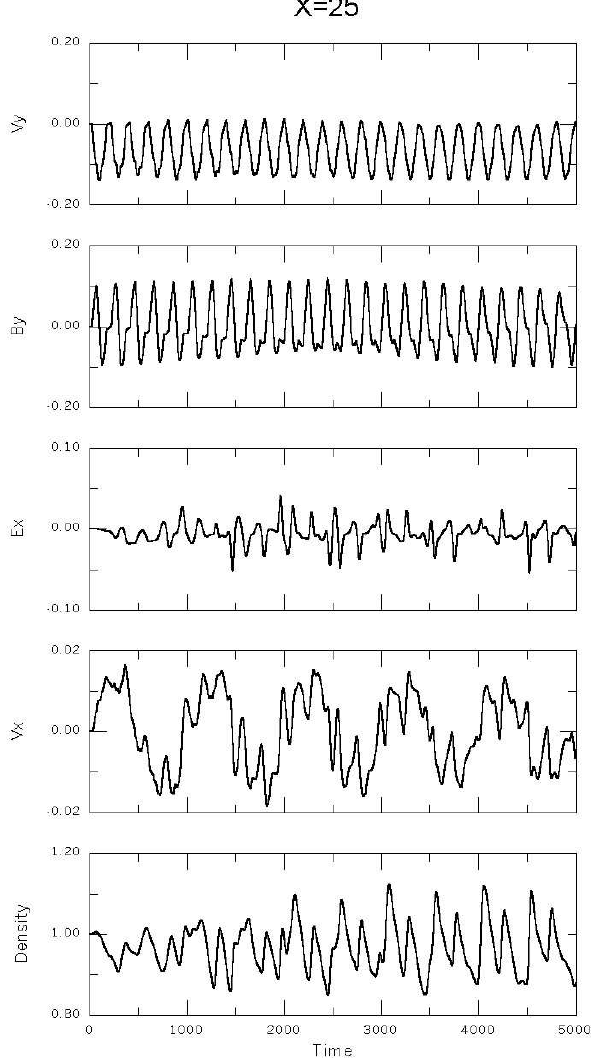
Fig. 3. Time variation of the plasma parameters at the distance x =25 (quarter of the simulation box). From top to bottom: transverse components of the velocity v y and the magnetic field B y , parallel electric field E x and parallel velocity v x , and the plasma density n